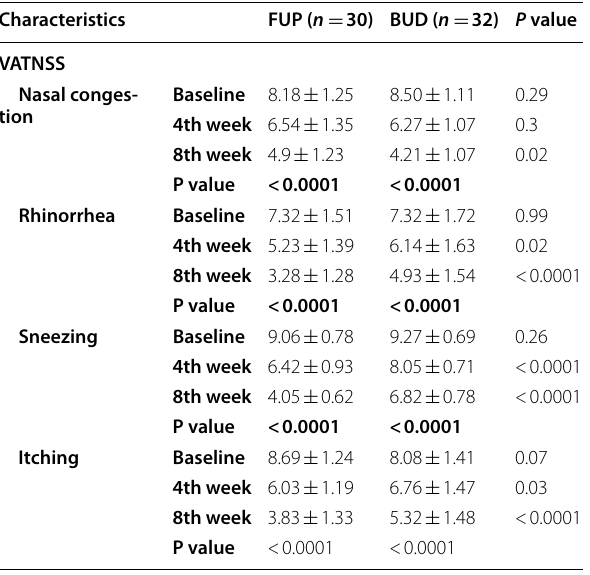
Table 2 Efficacy outcomes of visual analogue total nasal symptom scores